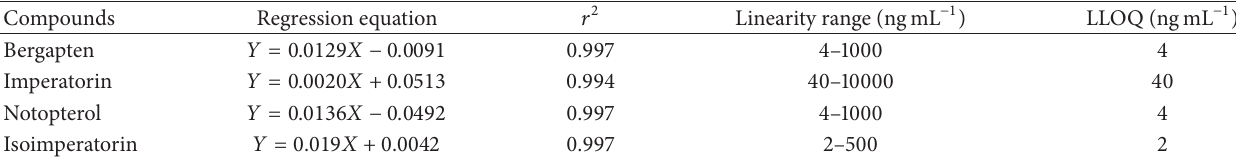
Figure 2: Representative chromatogram of (a) blank rat plasma, (b) blank rat plasma spiked with standard compounds, and (c) real sample after oral administration of N. incisum . 1: bergapten, 2: imperatorin, 3: notopterol, 4: osthole, and 5: isoimperatorin. Table 1: Calibration curve and LLOQ.